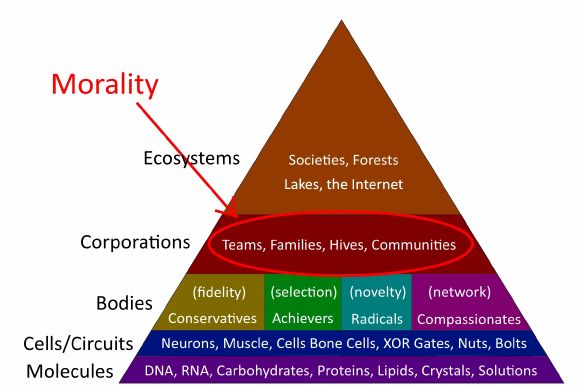
Figure 2: Less-anthropocentric